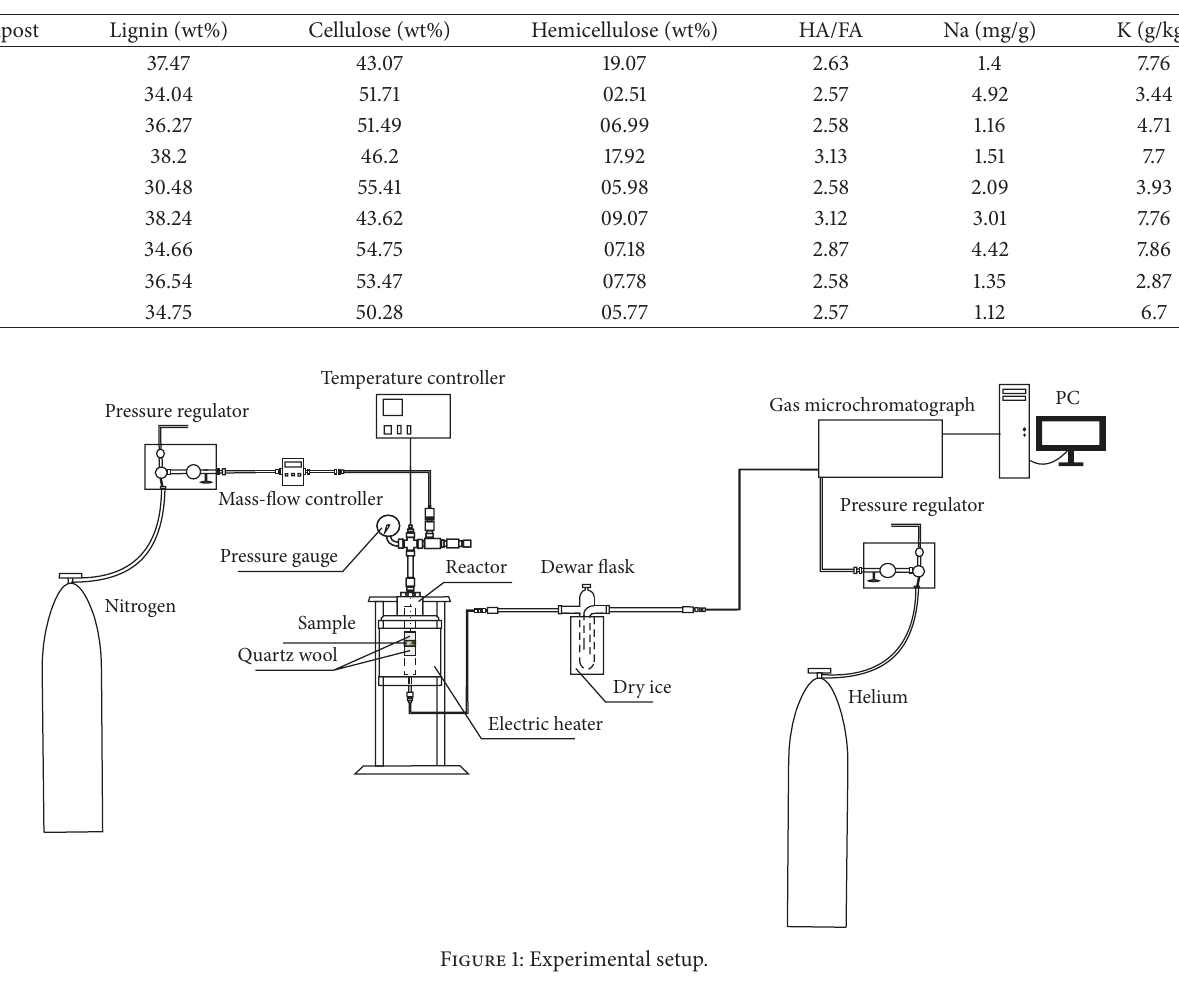
Table 3: Biochemical components, humic to fulvic acids ratio, and water-soluble alkali contents of composts.